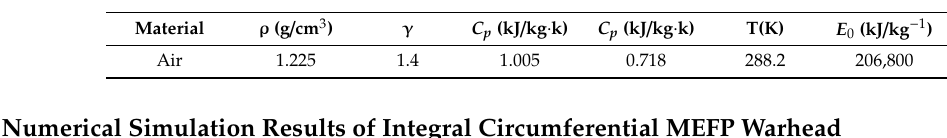
Table 4. Material parameters of air.